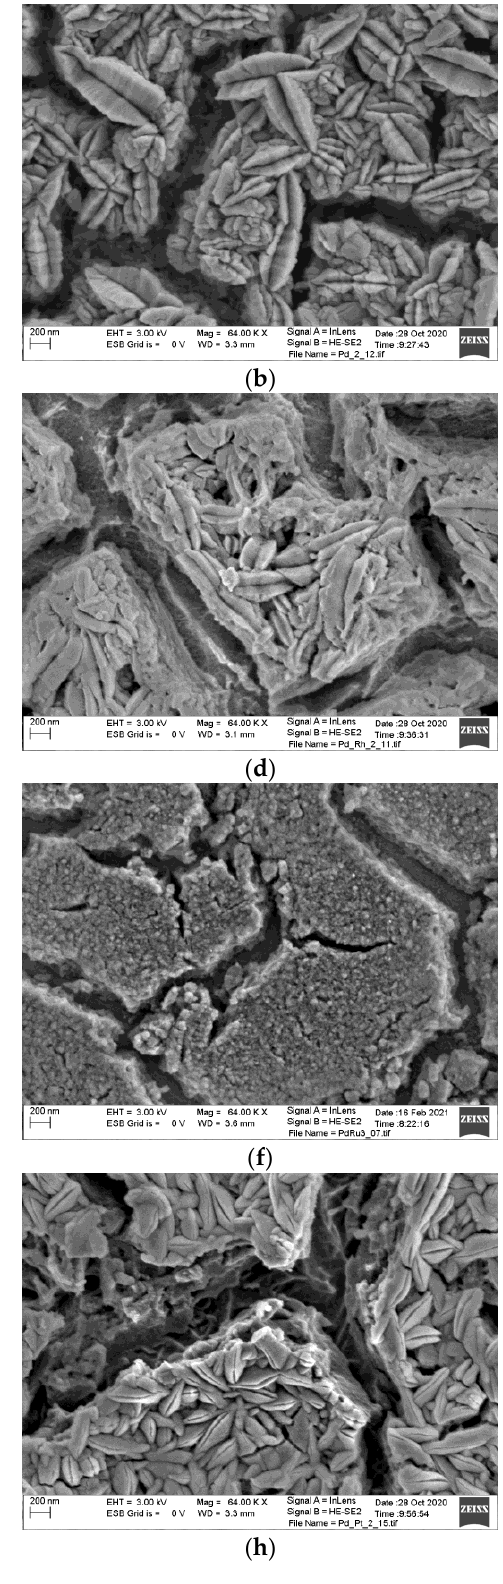
Figure 1. Surface morphology of the electrodeposited Pd and Pd-based alloys: ( a ) As–deposited Pd; ( c ) As–deposited Pd-Rh; ( e ) As–deposited Pd-Ru; ( g ) As–deposited Pd-Pt; ( b ) Pd after corrosion; ( d ) Pd-Rh after corrosion; ( f ) Pd-Ru after corrosion; ( h ) Pd-Pt after corrosion.